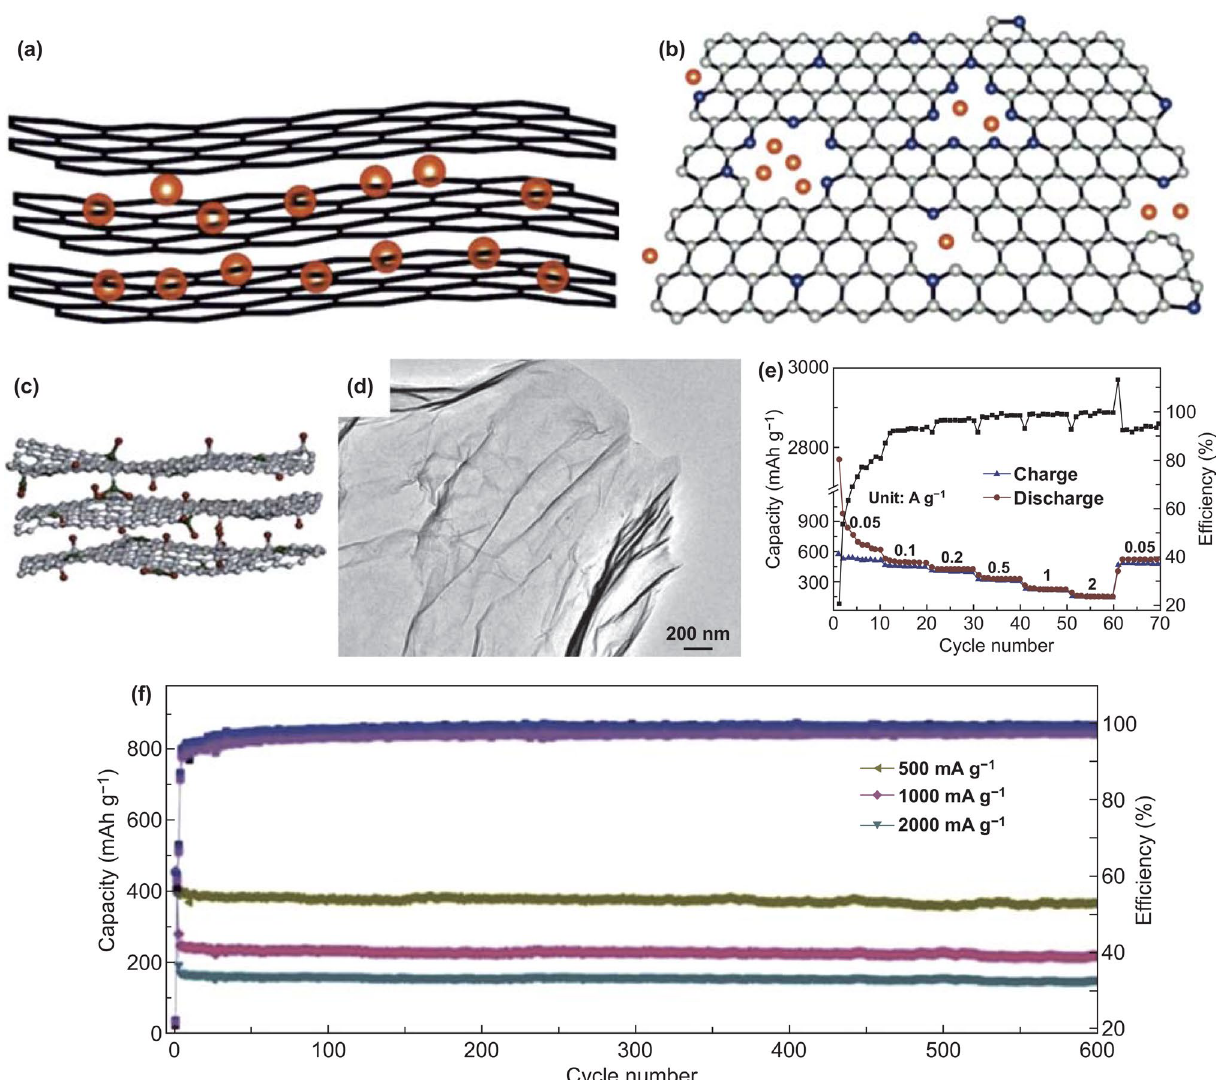
Fig. 9 Schematic diagram of K + trapped a in the surface and b in the defect sites. Reproduced with permission from Ref. [65]. Copyright 2018, Elsevier. c Schematic diagram and d TEM image of PODG. e The rate capability of the PODG electrode. f Cycle capacities of the obtained anode under three different current densities. Reproduced with permission from Ref. [66]. Copyright 2017, Royal Society of